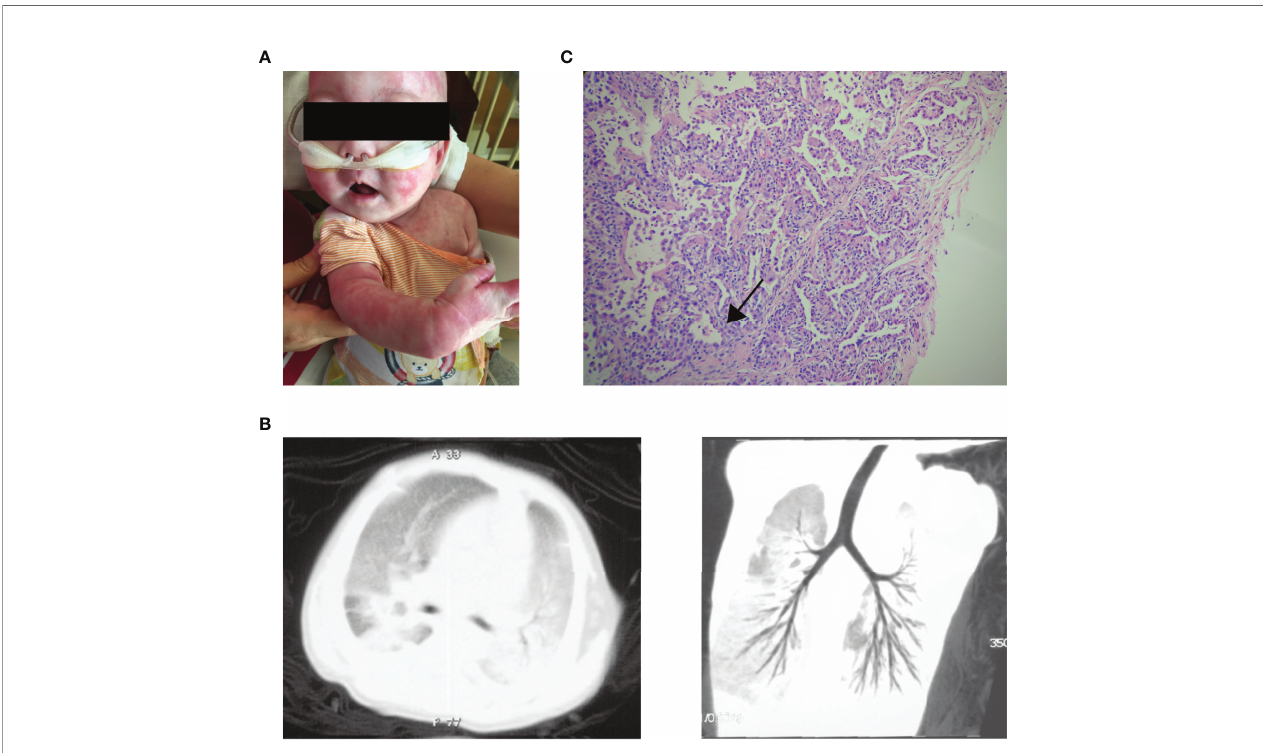
FIGURE 1 | The clinical manifestations of the patient. (A) Generalised eczematous skin rashes in the patient. (B) Chest computed tomographic scan of the patient shows interstitial lung disease with diffuse ground-glass opacity. (C) Histology of lung biopsy from the patient. The alveolar membranes were markedly thickened (arrow) with macrophages, lymphocytes, and granulocytes in the alveolar